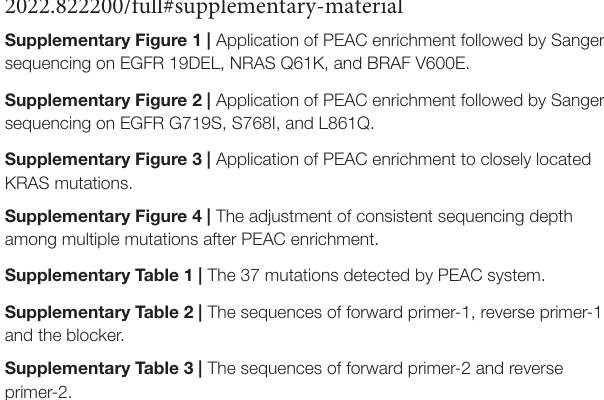
Supplementary Figure 1 | Application of PEAC enrichment followed by Sanger sequencing on EGFR 19DEL, NRAS Q61K, and BRAF V600E. Supplementary Figure 2 | Application of PEAC enrichment followed by Sanger sequencing on EGFR G719S, S768I, and L861Q. Supplementary Figure 3 | Application of PEAC enrichment to closely located KRAS mutations. Supplementary Figure 4 | The adjustment of consistent sequencing depth among multiple mutations after PEAC enrichment. Supplementary Table 1 | The 37 mutations detected by PEAC system. Supplementary Table 2 | The sequences of forward primer-1, reverse primer-1, and the blocker. Supplementary Table 3 | The sequences of forward primer-2 and reverse